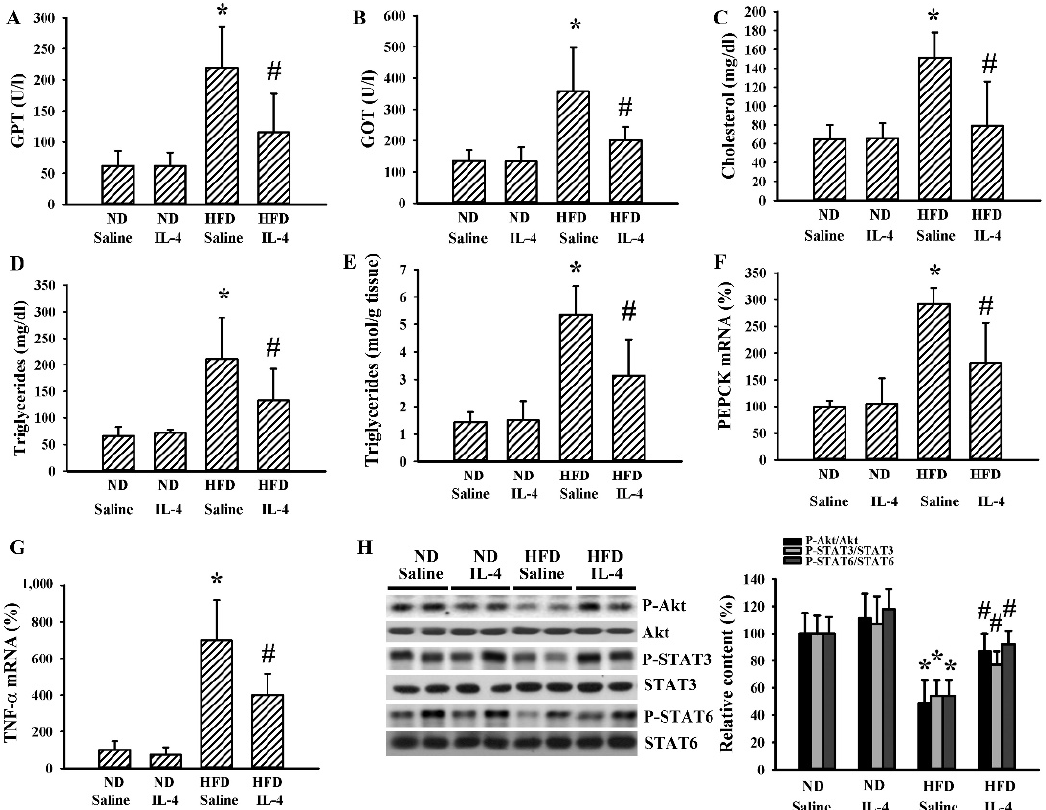
Figure 8. IL‐4 ameliorated hepatic changes in leptin‐resistant mice. C57BL/6 mice were fed the normal diet (ND) or high‐fat diet (HFD) for 12 weeks. Simultaneously, normal saline and IL‐4 (1 μg/mouse) were intraperitoneally administrated twice a week for the last 8 weeks. Blood samples were collected and GPT ( A ), GOT ( B ), total cholesterol ( C ), and triglyceride ( D ) levels measured. Hepatic tissues were collected and subjected to measurement of triglycerides ( E ). Total RNAs were extracted from the hepatic tissues and mRNA expression measured with qRT‐PCR for PEPCK ( F ) and TNF‐α ( G ). Proteins were extracted from the hepatic tissues and subjected to Western blot analysis with indicated antibodies. Representative blots and quantitative data are shown ( H ). * p < 0.05 vs. ND/saline group and # p < 0.05 vs. HFD/saline group, n = 6.